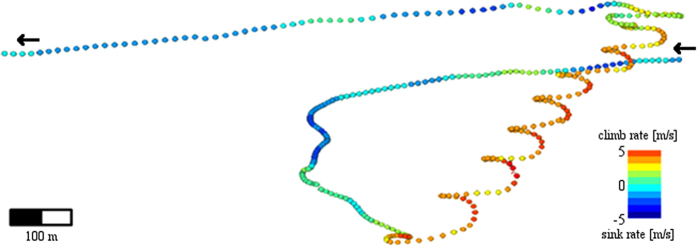
An example of a flight path of an adult vulture.Flight alternating between gliding (blue sections) and thermal soaring (ranging from yellow to red) modes. Flight took place on August 24th, 2013, in the Negev Desert. See Movie S1 for an animation of a daily flight.